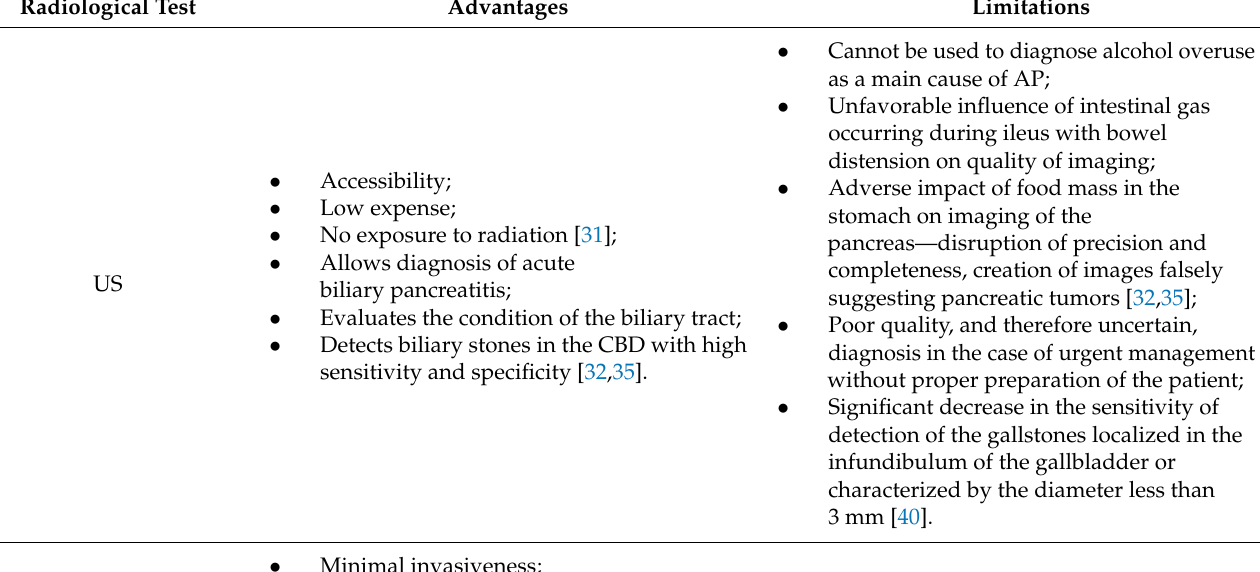
Table 3. Summary of the radiological tests utilized in acute